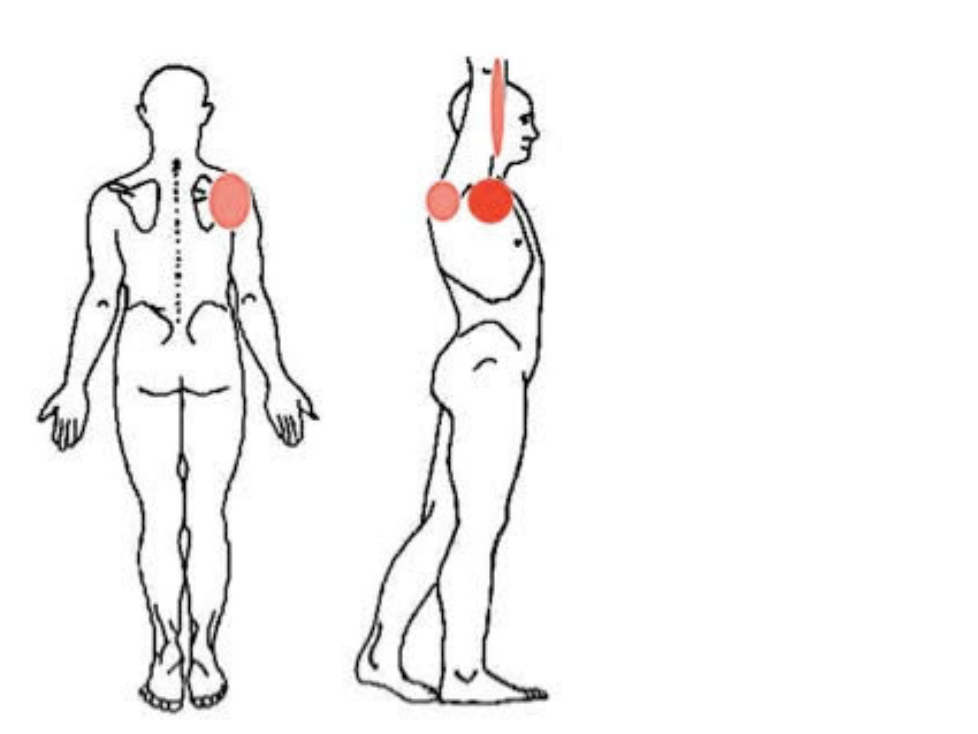
Figure 2. Body chart after 1 month. Bright red indicates the most painful body areas; pale red indicates the mildly painful body areas.